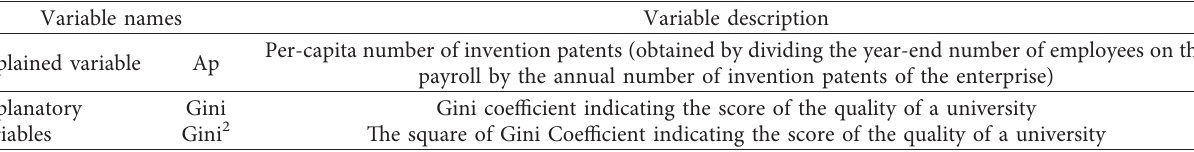
Table 1: The selection and description of enterprises’ variables.